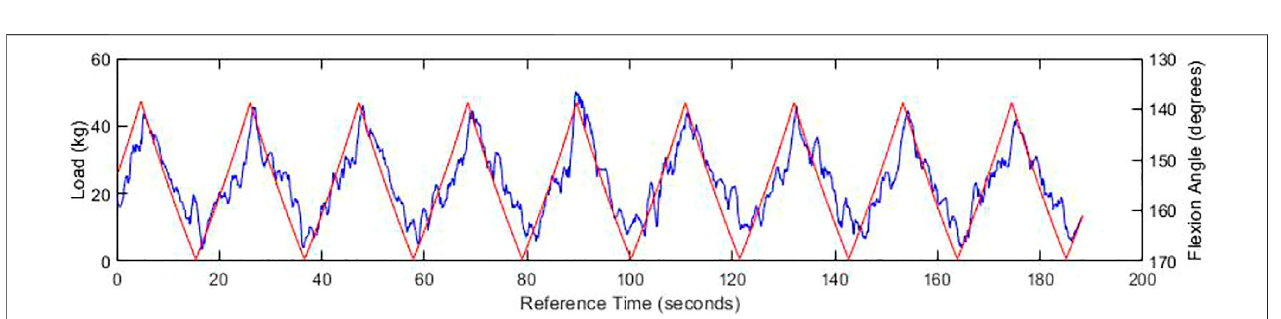
FIGURE 7 | Graph of experienced load (blue) and fl exion angle (red) at 1.1 V, with an SG fi ltration of the load function.